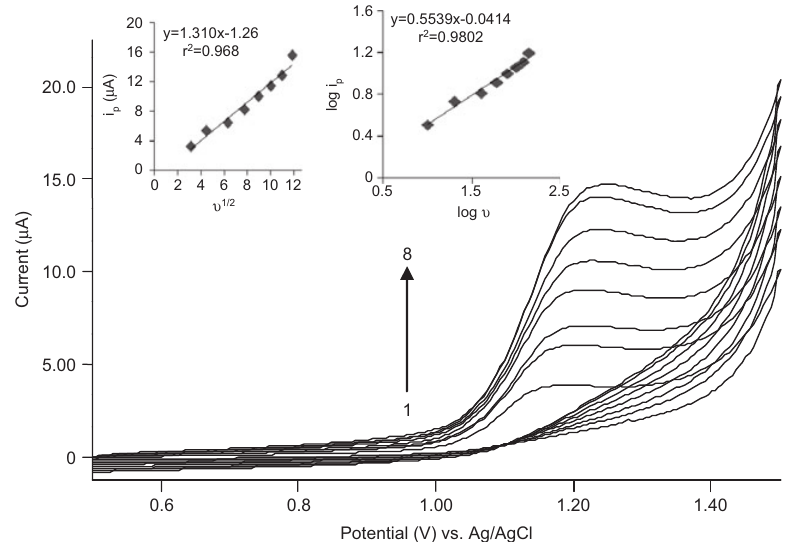
Figure 2 The CVs of 1.0 × 10 -4 m gatifl oxacin in the acetate buffer of pH 5.0 at multi-walled carbon nanotube paste electrode (MWCNTPE), pulse amplitude 50 mV, scan rate 50 mVs -1 , current range 10 μ A. Scan rates (1) 10 mVs -1 , (2) 20 mVs -1 , (3) 40 mVs -1 , (4) 60 mVs -1 , (5) 80 mVs -1 , (6) 100 mVs -1 , (7) 120 mVs -1 and 140 mVs -1